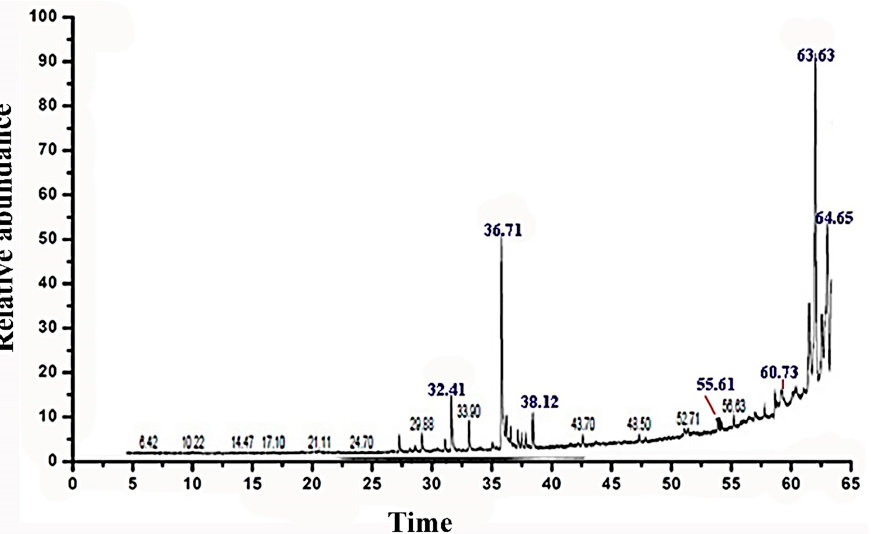
Figure 5. Chromatogram of ethanolic extract of C. procera leaves by gas chromatography–mass spectrometry (GC–MS) analysis. The GC–MS spectrum at retention time 0-65 min represents the main compounds. Table 3. Identification of metabolites components produced by Streptomyces sp . strain CALT_2 us- ing gas chromatography–mass spectrometry (GC–MS) analysis.